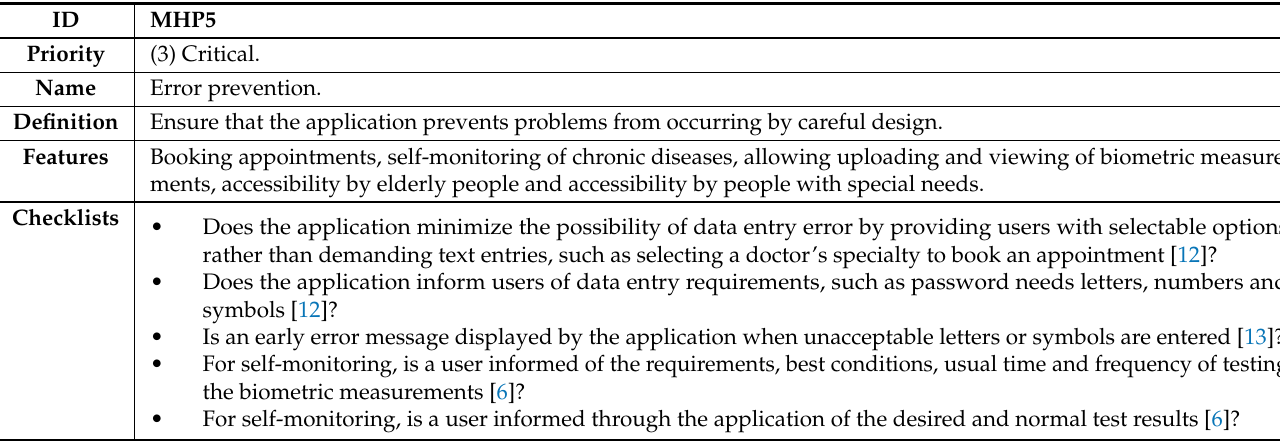
Table A5. Descriptive details of the fifth guideline.